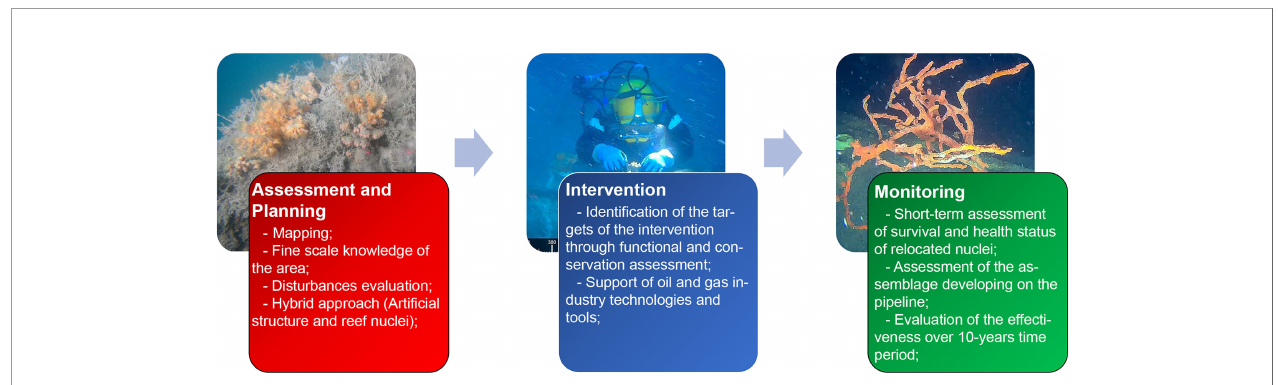
FIGURE 9 | The framework synthesis the intervention ’ s work fl ow, with assessment and planning, intervention, and monitoring representing the main steps to mitigate the interference between TAP and mesophotic reefs built by